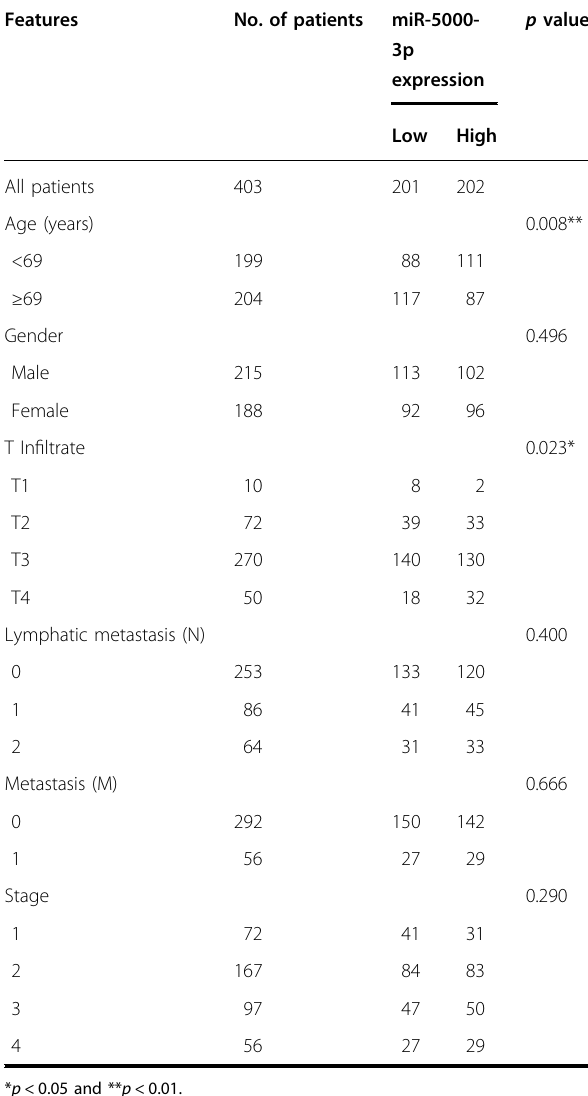
Table 1 Relationship between miR-5000-3p expression and tumor characteristics in patients with colorectal